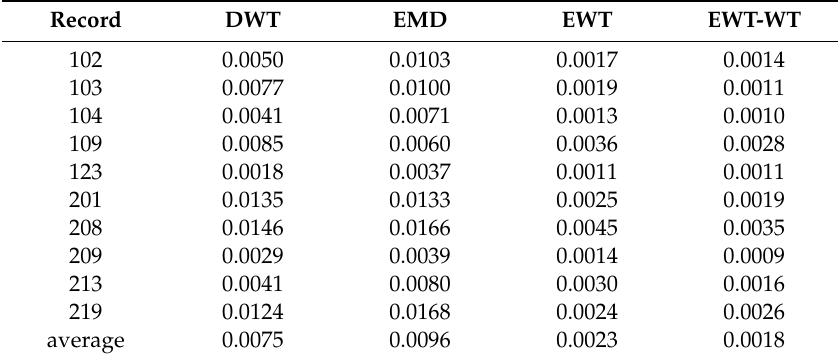
Table 1. The MSE of the output ECG signals using DWT, EMD, EWT and EWT-WT methods.